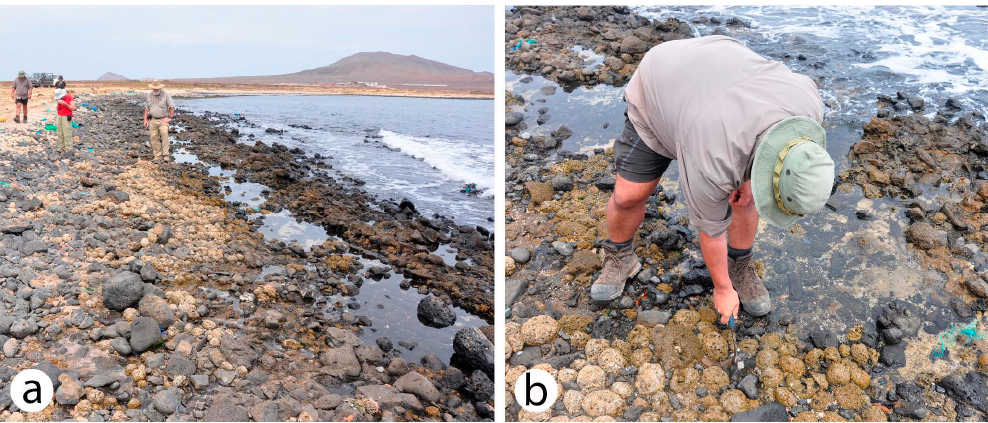
Figure 4. Patchy exposure of upper Pleistocene rhodolithic limestone at the north end of Praia das Gatas on the east coast of Sal Island in the Cabo Verde archipelago; ( a ) View to the north at low tide showing a thin deposit of rhodoliths on a conglomerate of basalt cobbles and small boulders; ( b ) Closer view of a single layer of rhodoliths approximately 10 cm in